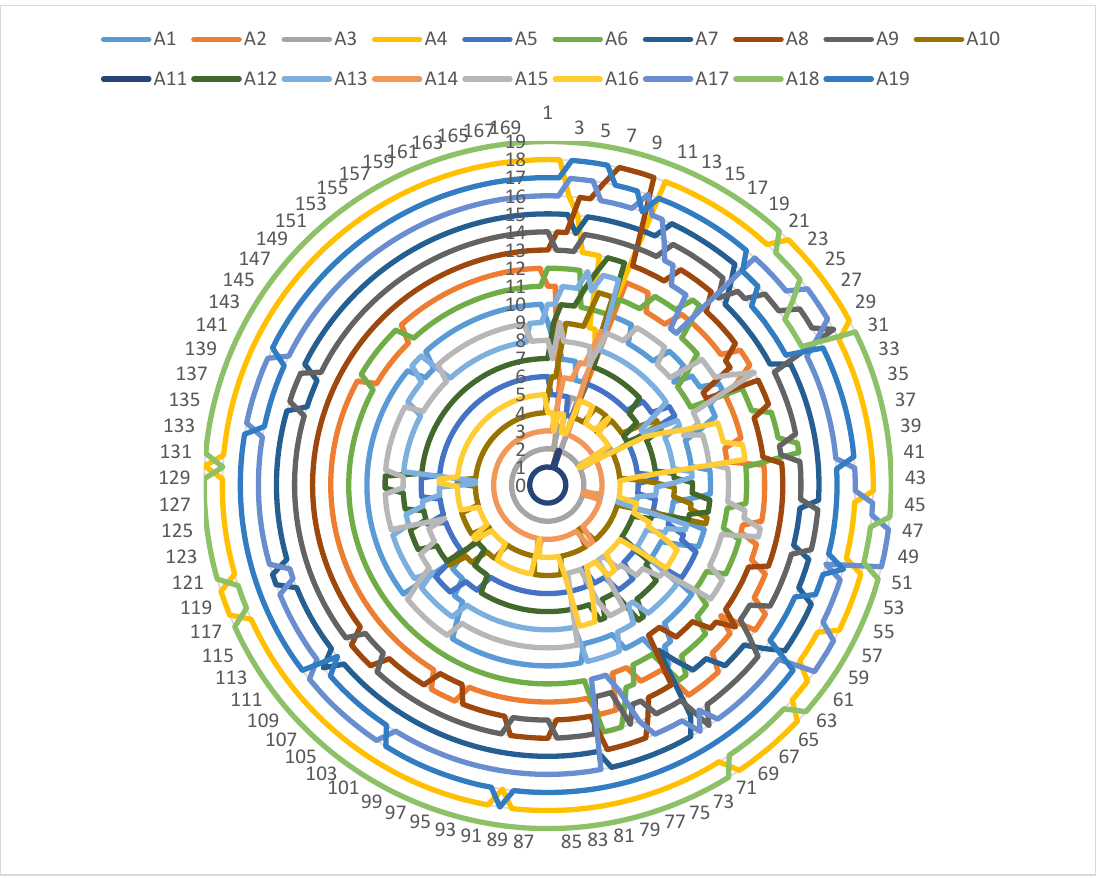
Fig. 2. Impacts of modifications of criteria weights on the ranking results for 101 scenarios